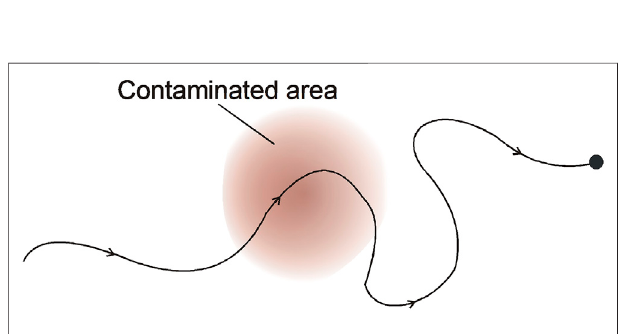
FIGURE 15 | Where have you